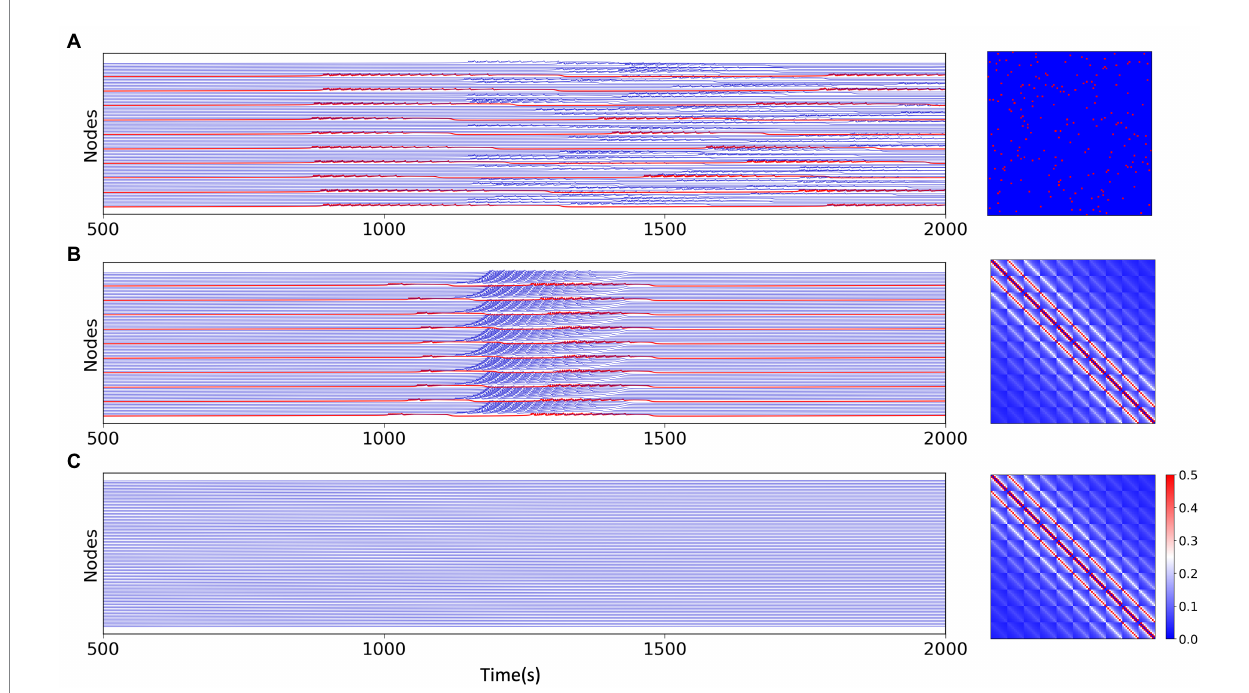
FIGURE 3 Simulation results for the network model with different network connections and different excitations, the connection matrix is shown on the right. (A) Simulation results of the multi-node network model under the random network, where the excitatory nodes (red) can have state switching and a portion of the non-excitatory nodes remain in the stable state. (B) Simulation results of the multi-node model with fully connected network. Except for excitatory nodes (red), all non-excitatory nodes generate state switching, which is slightly delayed than excitatory nodes. (C) Simulation results of the model without excitatory nodes under fully connected network connections, all nodes do not have state